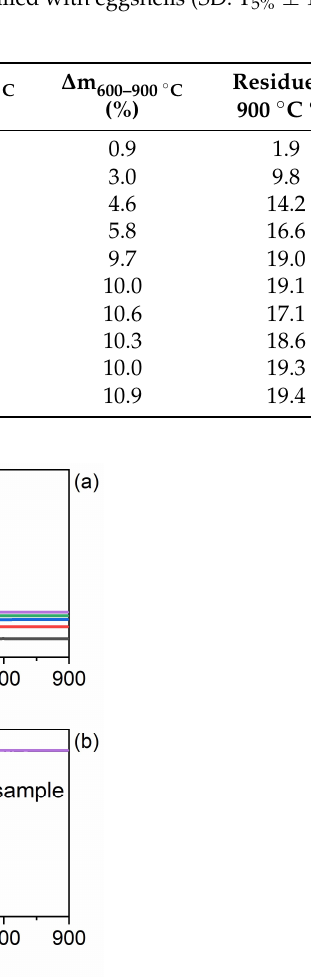
Figure 12. TG and DTG curves of NR vulcanizates filled with 40 phr of ground eggshells contain- ing silanes, ILs, and CTAB: ( a ) TG curves; ( b ) DTG curves. The results of TG analysis presented in Table 9, showed that ground eggshells and their amount did not significantly affect the onset decomposition temperature (T 5% ) of the NR vulcanizates. Thermal decomposition of the unfilled sample started at a tempera- ture of 322 °C, and the main degradation process occurred at 398 °C with a mass loss of 97.1%. Introducing 10 phr of eggshells reduced the T 5% by approximately 3 °C compared to the unfilled benchmark. However, the T 5% increased with increasing the amount of biofiller in the vulcanizate, and for the vulcanizate filled with 40 phr of eggshells, T 5% was 328 °C, so 6 °C higher compared to the unfilled NR. Furthermore, ground eggshells had no significant impact on the T DTG , which was determined as the temperature of the maximum rate of the vulcanizates mass loss. T DTG of the studied vulcanizates ranged from 395 °C to 398 °C. Exposure to elevated temperature results in several changes in physical or chemical composition of biocomposites which can lead to their degradation. Improving thermal degradation is equal with improving thermal stability of the bio- composite. This property is undoubtedly affected by such parameters as lower % of